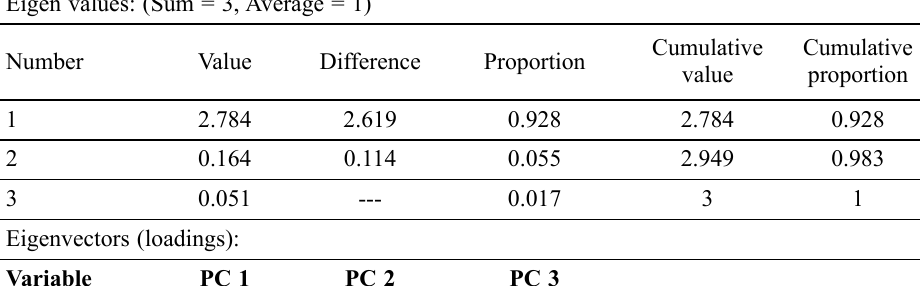
Table 1. Principal components